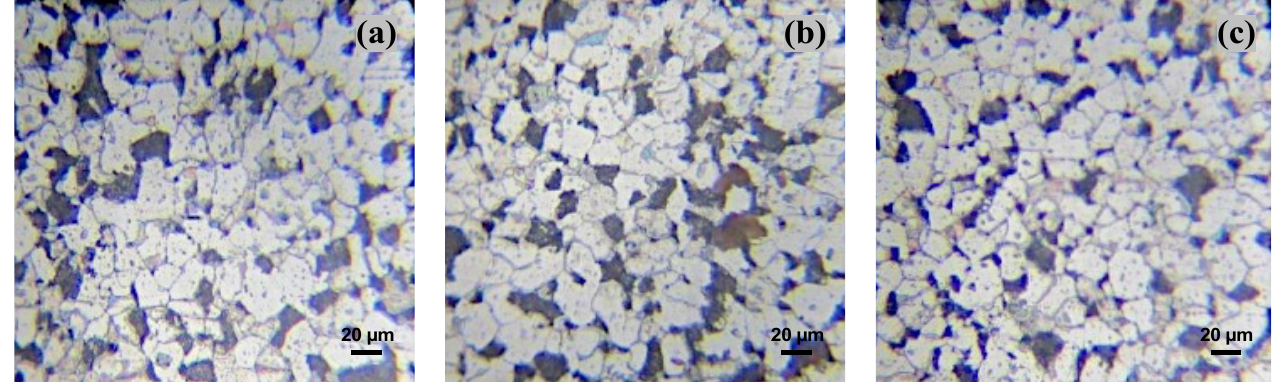
Figure 1. ( a ) and ( b ) and ( c ) normal original metallographic organization of 12Cr1MoV steel at dif- Figure 1. ( a – c ) normal original metallographic organization of 12Cr1MoV steel at different locations. ferent locations.